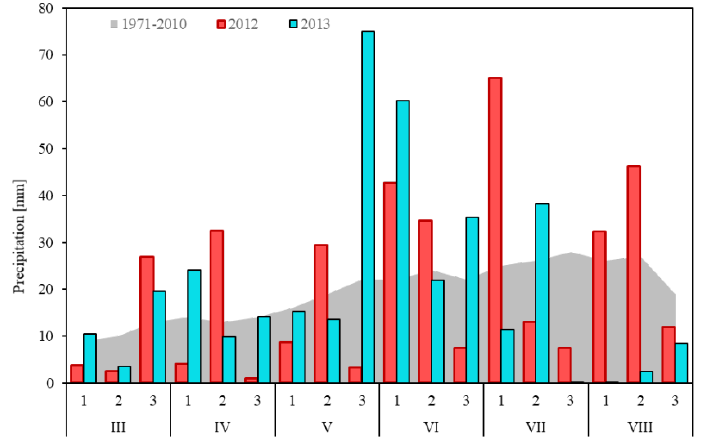
Figure 8. The average decade sum of precipitation in year 2012–2013 and period 1971–2010.